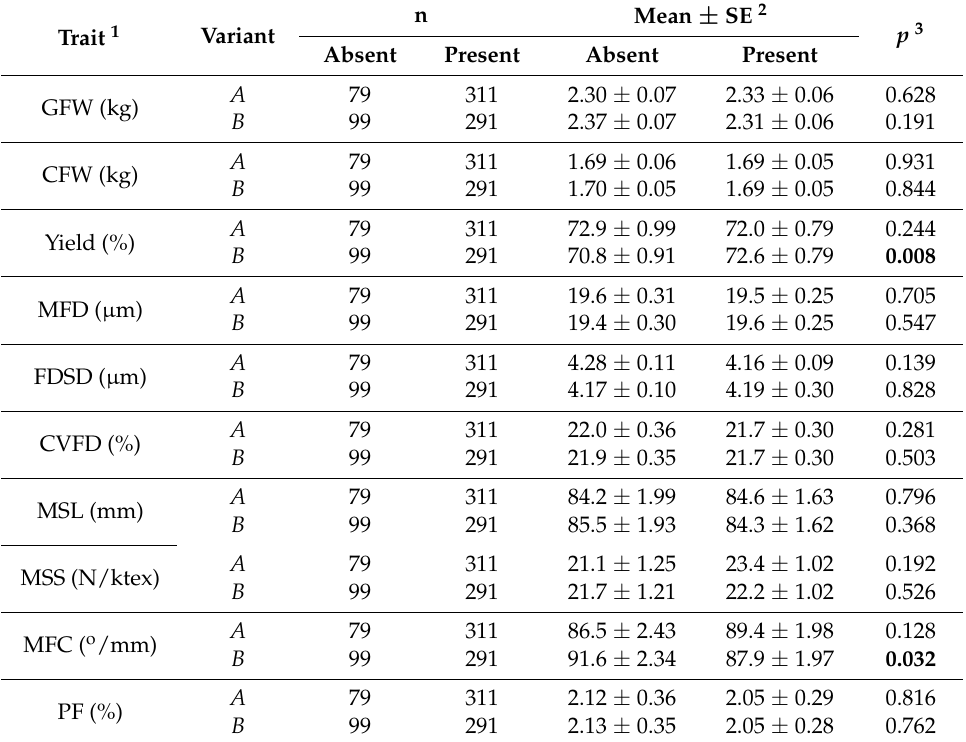
Table 2. Association of KRTAP22-1 variants with various wool traits.